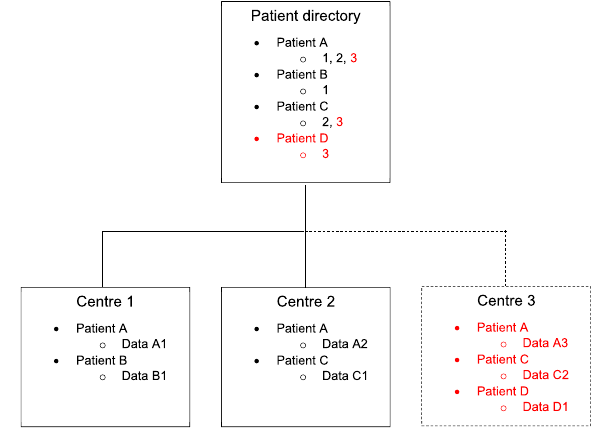
Fig. 3 Connecting independent healthcare providers. Each box represents a Blockchain ledger. The Patient Directory lists all pseudonymised patients about whom data is stored across all providers ’ Blockchain ledgers. Associated with each patient is a pointer to all centres (represented by number) where that individual has had a medical interaction. Individual Centres store their own ledgers, containing more detailed metadata (represented by code, e.g. Data A1, which does not imply storage of sensitive medical information) about interactions with patients, including associated cloud-based data storage locations and access permission informa- tion. When a Centre joins the system (e.g. Centre 3), basic pseudonymised information about its patients is relayed to the Patient Directory, allowing other Centres to access that information, subject to any associated smart contract-based